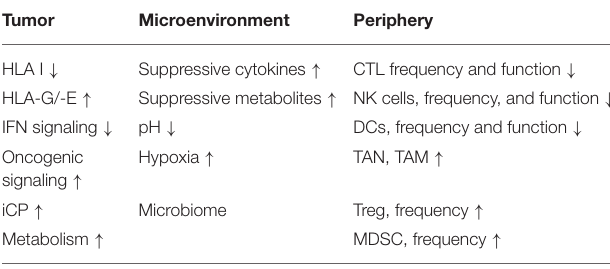
TABLE 1 | Immune escape mechanisms.